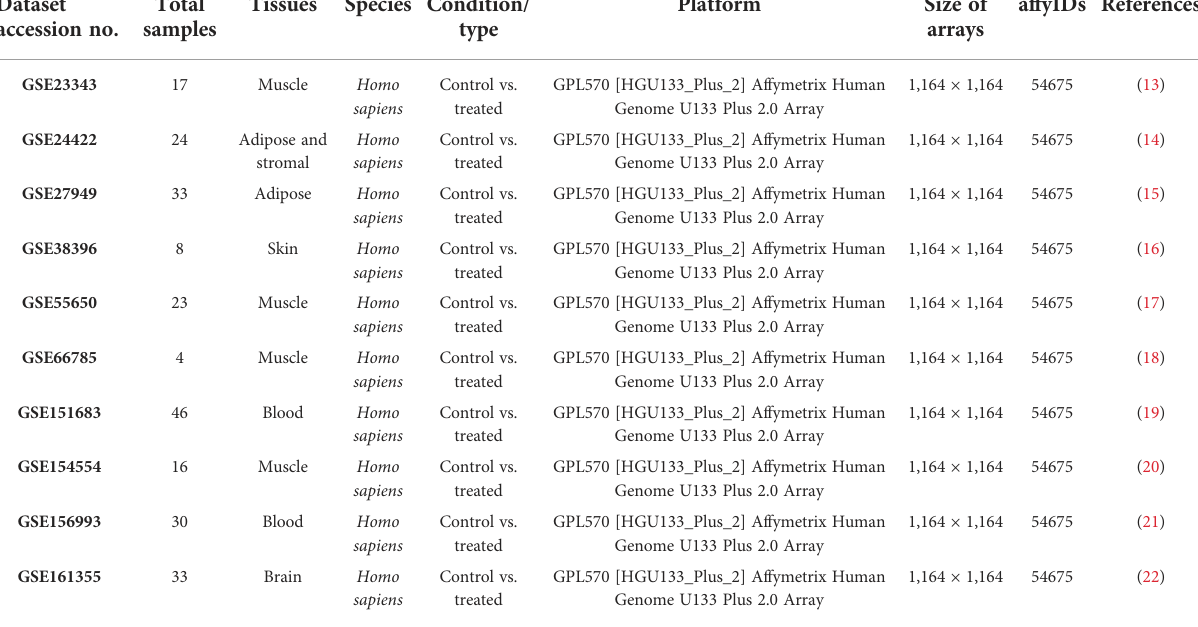
TABLE 1 cDNA datasets obtained from the GEO databases. Dataset accession